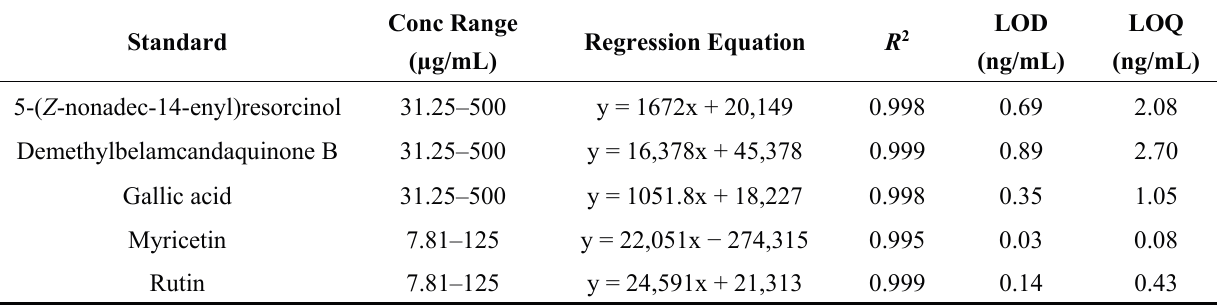
Table 3. Regression parameter, LOD and LOQ of the HPLC